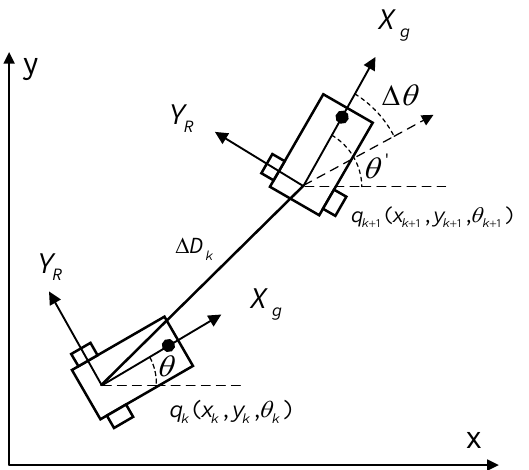
Figure 4. The motion model of the moving